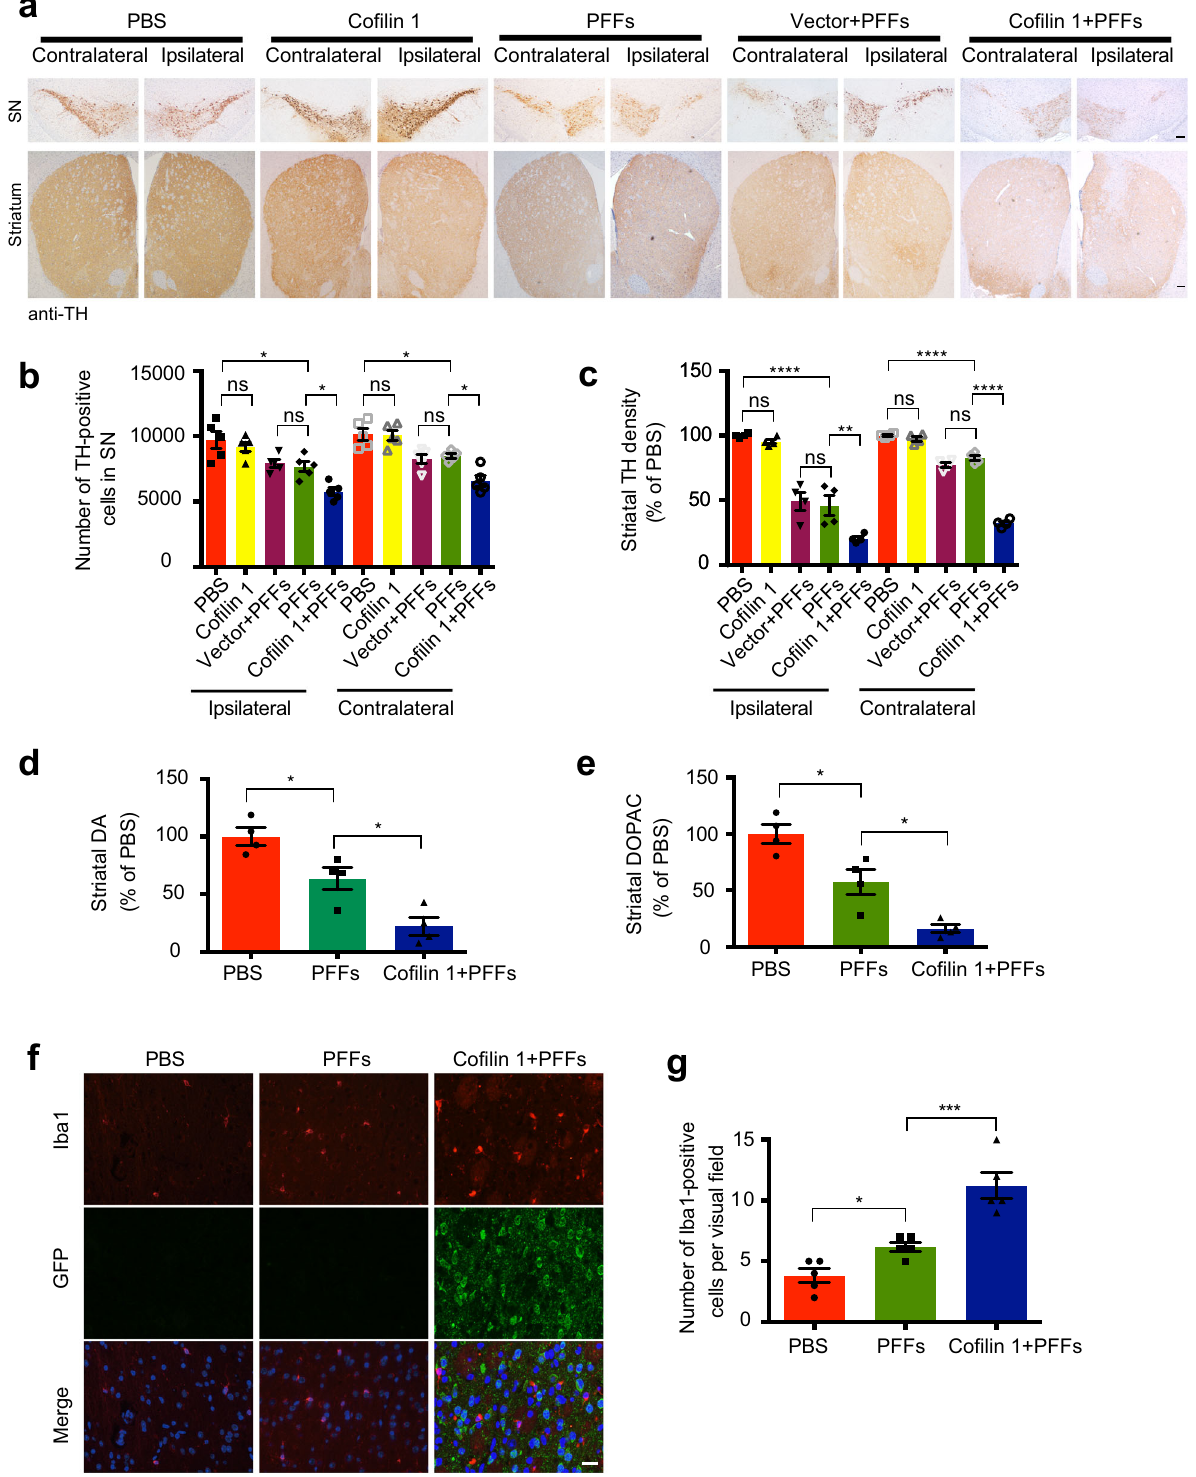
Fig. 5 Co fi lin 1 promotes the degeneration of dopaminergic neurons induced by α -synuclein fi brils in vivo. a – c TH immunostaining of the striatum and substantia nigra (SN). The number of TH-positive neurons in the SN and the density of striatal dopaminergic terminals were quanti fi ed. Scale bars, 100 μ m. Data are mean ± SEM; n = 4 – 5; * P < 0.05, ** P < 0.01, **** P < 0.0001, ns: not statistically signi fi cant by one-way ANOVA. d , e Concentrations of DA and DOPAC in the striatal tissues, as determined by HPLC. Data are mean ± SEM; n = 4 mice per group; * P < 0.05 by one-way ANOVA. f , g Co fi lin 1 promotes microglia activation. Immunostaining showing the Iba1-positive microglia in the striatum. Scale bar, 20 μ m. Data are mean ± SEM; n = 5; * P < 0.05, *** P < 0.001 by one-way